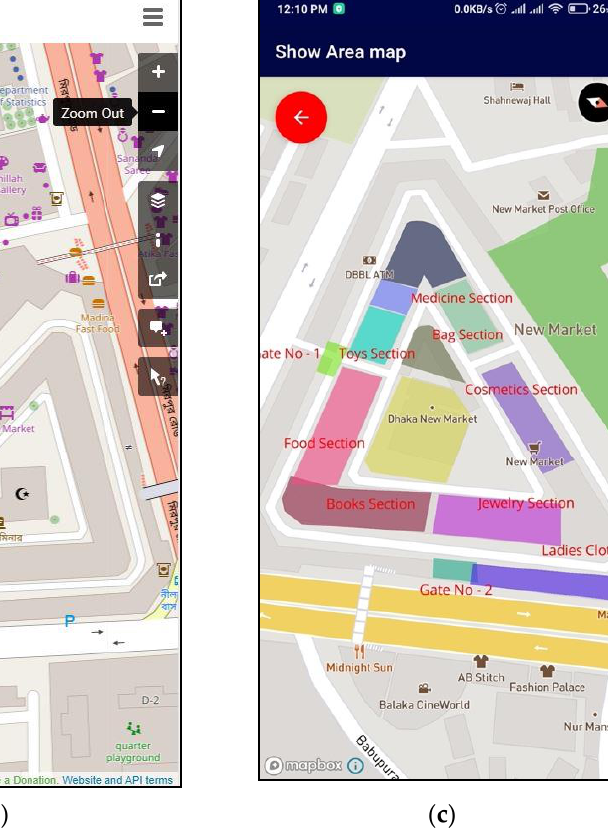
Figure 14. ( a ) Google Map view, ( b ) OpenStreetMap view, and ( c ) proposed application. For creating a surface map of an academic building, North South University, situated in Bashundhara Residential Area, Dhaka, Bangladesh, was chosen. The institutional map by Google Maps and the proposed application are given in Figure 15a,b, respectively. The upper view is shown by both applications, which does not differ much. Figure 15b contains details needed by a student to explore the area, which are missing in Figure 15a.